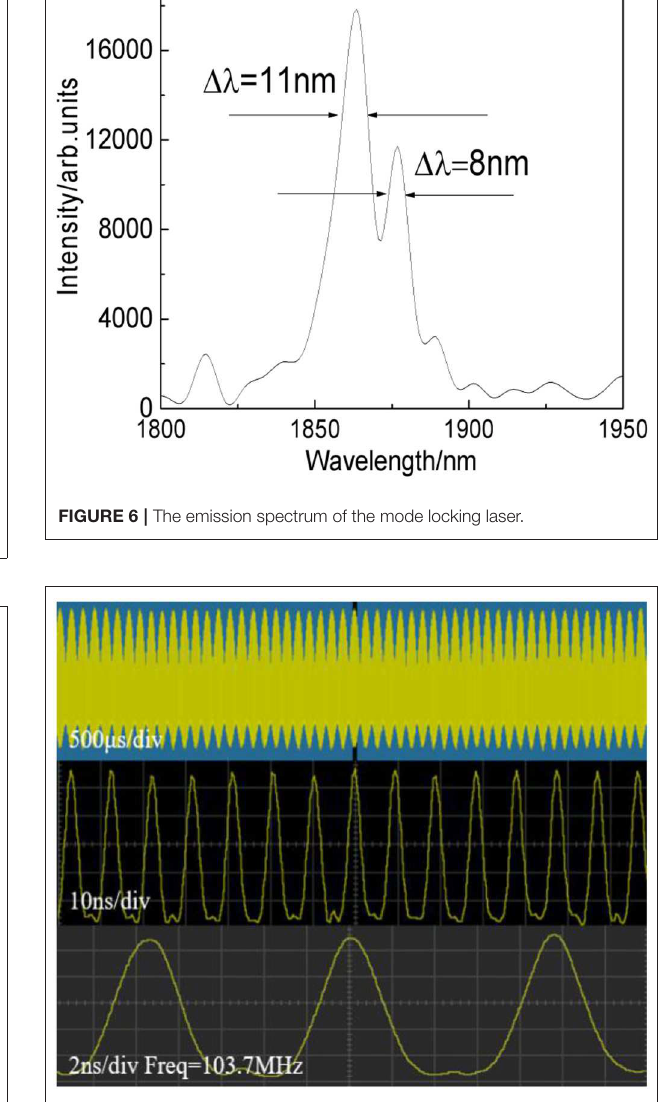
FIGURE 7 | Mode-locked pulse